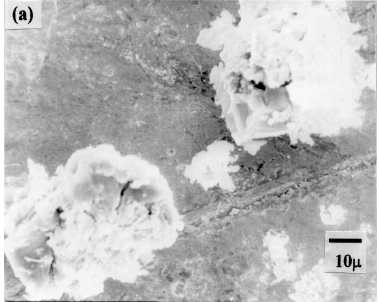
obtained after heat treatment at 750 o C. 3